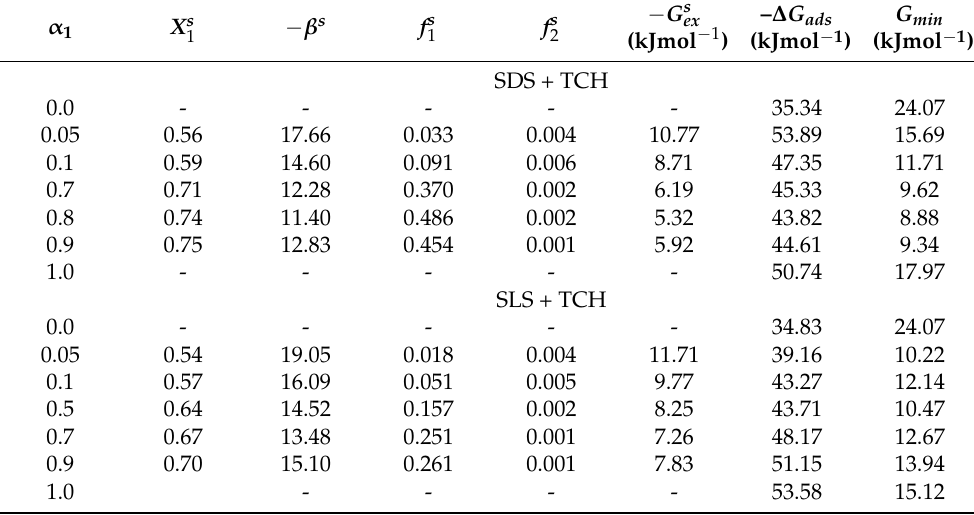
/ f s 2 ) = 0.04, u r ( G s ex ) = 0.03, 1